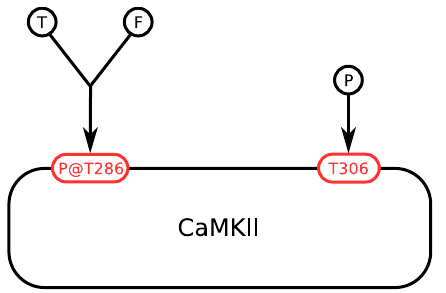
Figure 2.38: Two examples of state variables used to represent phophorylation of a threonine residue. While only the value “phosphorylated” is assigned to T306, the variable T286P can take the values true or false, which allow for representing dephosphorylation as well as